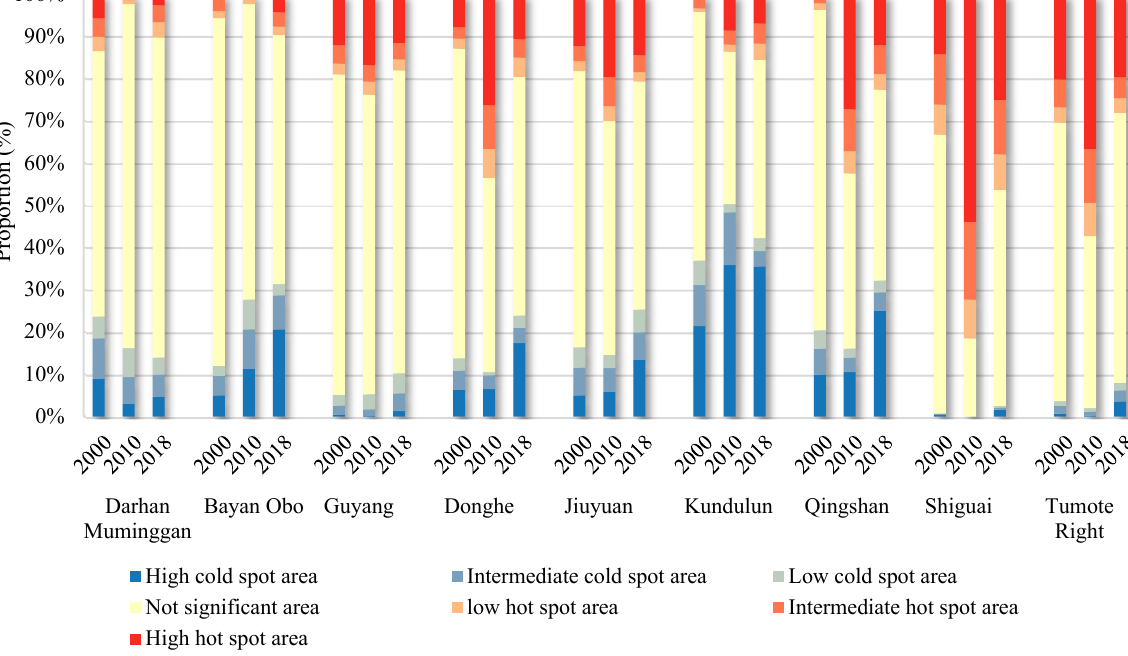
Table 5. Coefficient of sensitivity of ESV.